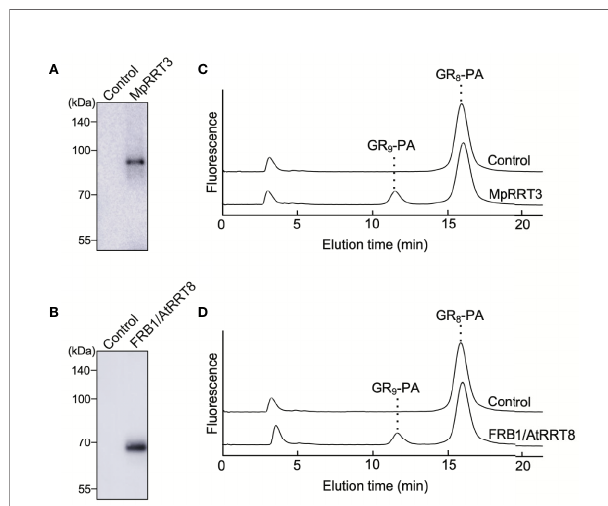
FIGURE 7 | MpRRT3 and FRB1/AtRRT8 have RG-I rhamnosyltransferase activity. (A, B) SDS-PAGE of the recombinant (A) MpRRT3 and (B) FRB1/ AtRRT8 proteins with a C-terminal FLAG tag expressed in tobacco leaves. The proteins were detected by immunoblotting using an anti-FLAG antibody. (C, D) Rhamnosyltransferase activity of (C) MpRRT3 and (D) FRB1/AtRRT8. The recombinant proteins were reacted with 50 µM GR 8 -PA and 0.5 mM UDP-Rha at 30°C for 1 h. The upper and lower chromatograms represent after enzyme reactions with the fraction from control proteins and the recombinant proteins.